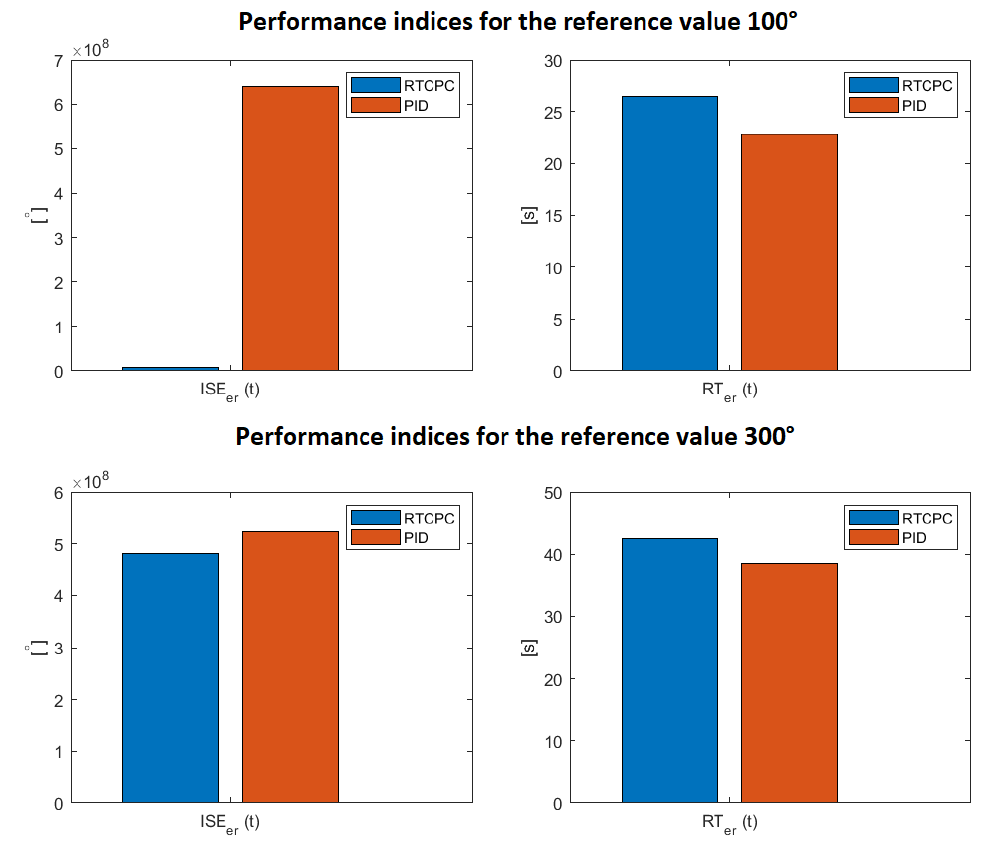
Figure 16. Graphical presentation of Table 4 (source: